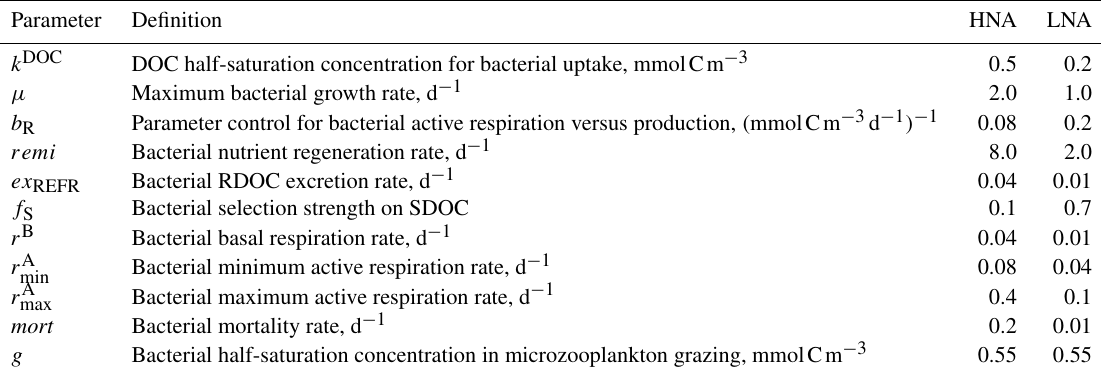
Table 1. Initial values of bacterial model parameters. Different initial values are assigned to the model parameters of high nucleic acid (HNA) and low nucleic acid (LNA) bacterial groups to simulate their distinct physiological processes and trophic interactions. Parameter